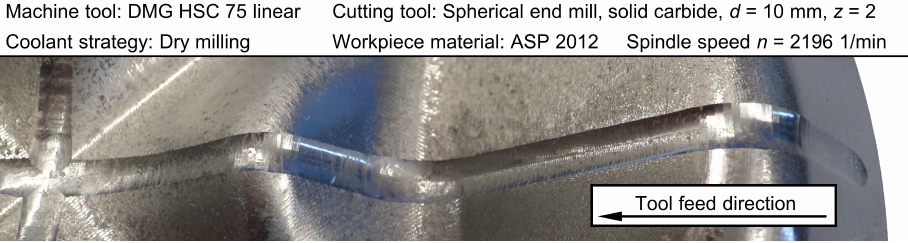
Figure 15. Workpiece used in the validation